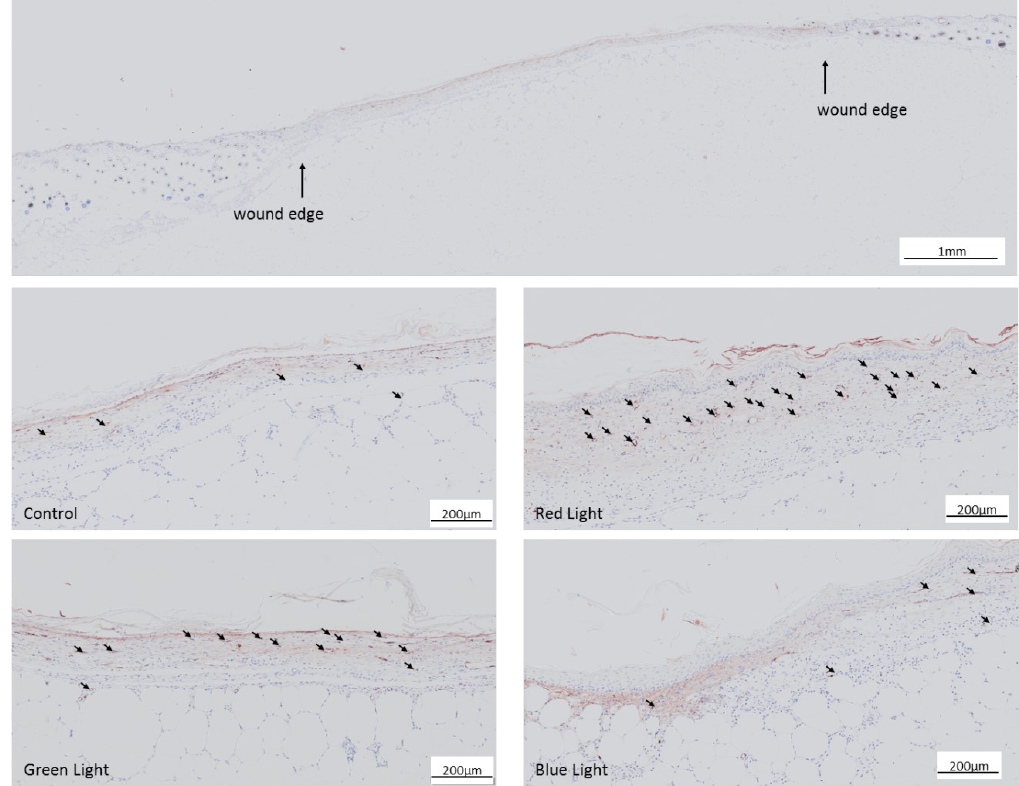
Figure 6. Example images of effects of pulsing light therapy of different wavelengths on the formation of new blood vessels in the wound area after the treatment period of 28 days. Blood vessels were visualized by vWF immunohistochemical staining and counted in the region of interest (ROI). Black arrows indicate vWF-positive blood vessels. The upper large picture shows an overview of the wound. The lower four pictures show blood vessel formation in the not illuminated control group and in the light treated groups. The shown area is within the wounded area. Black arrows point at examples of blood vessels.